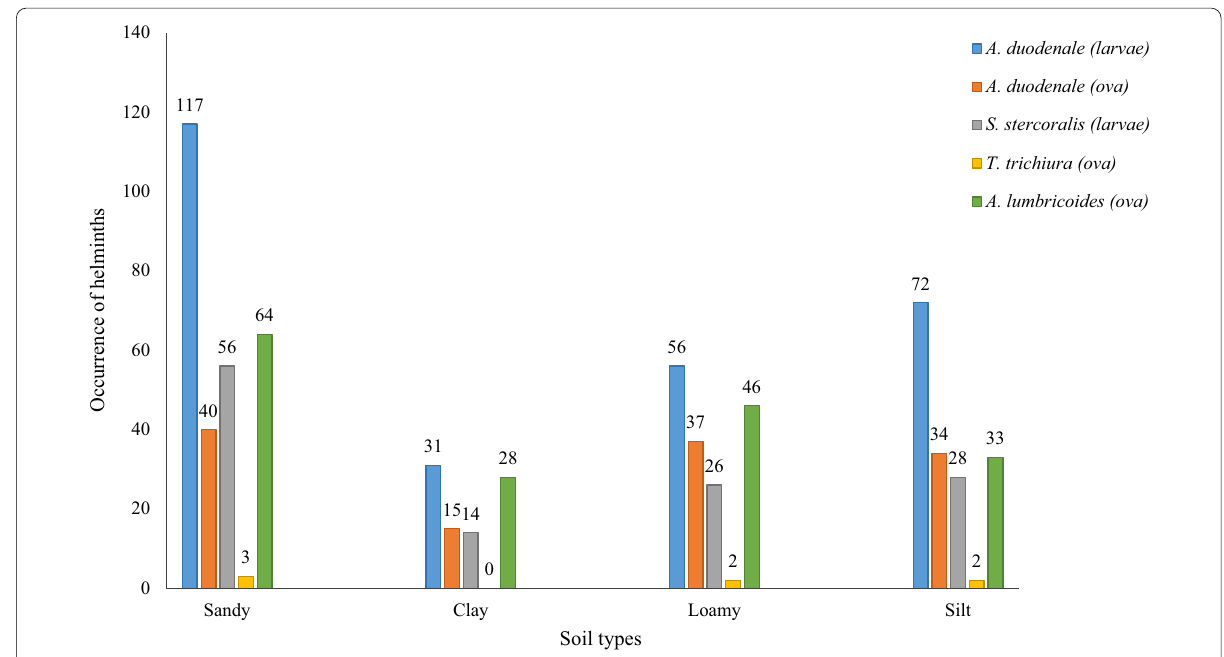
Fig. 3 Relationship between the occurrence of soil‑transmitted helminths and soil types